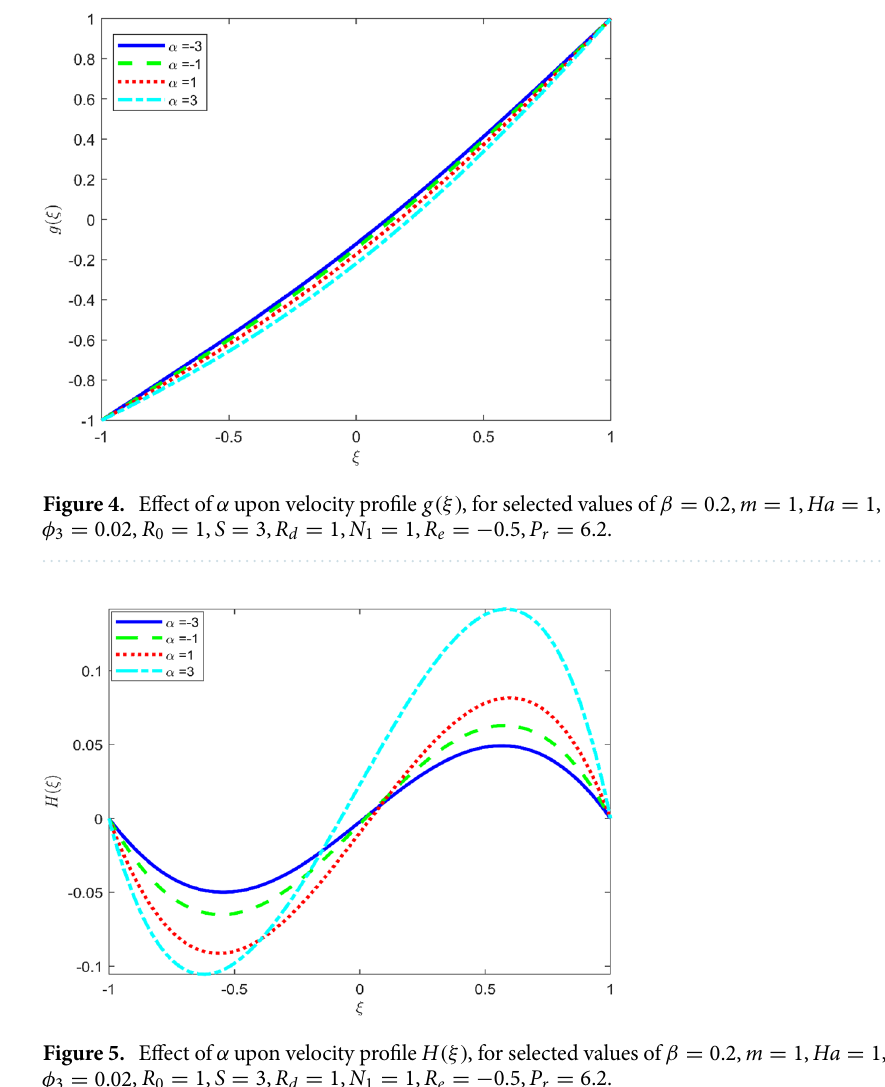
1, S 3, R 1, N 1 1, R 0.5, P e = − r = d = = = =